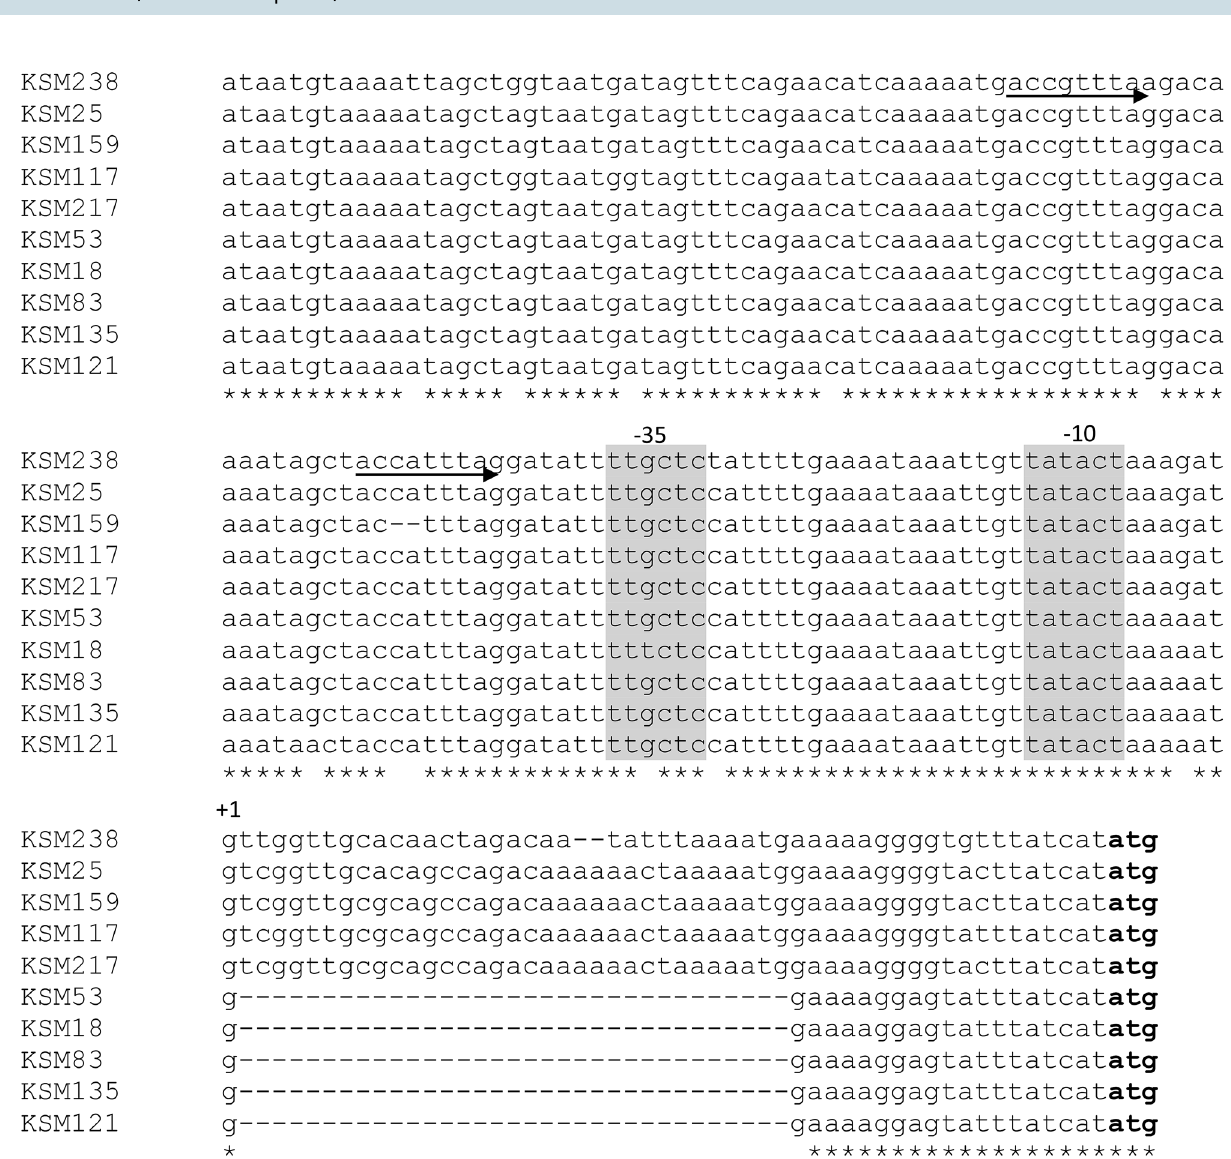
Figure 7. Comparison of the promoter region of mutacin IV gene between strains with strong and weak antibacterial activity. Nucleotide sequence upstream of nlmA in the strains with strong (KSM238 and KSM25) and weak antibacterial activity. The arrows represent the direct repeat sequences for the BrsR binding site. The bold letters represent the first codon of nlmA . Gray background represents the promoter region (− 35 and − 10